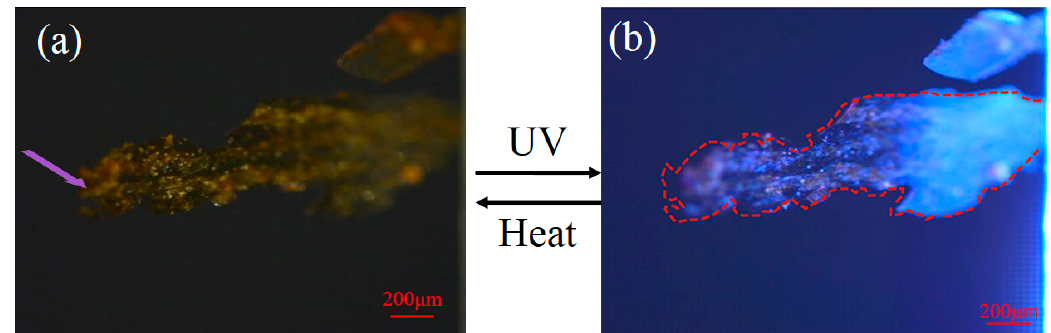
Figure 5. Photoinduced bending of a plate-like crystal (1446 μ m × 388 μ m × 5 μ m) of 6cazpy ( a ) before and ( b ) after UV irradiation from the bottom-left side (indicated by the purple arrow) and the red dashed line is the original position of crystal.